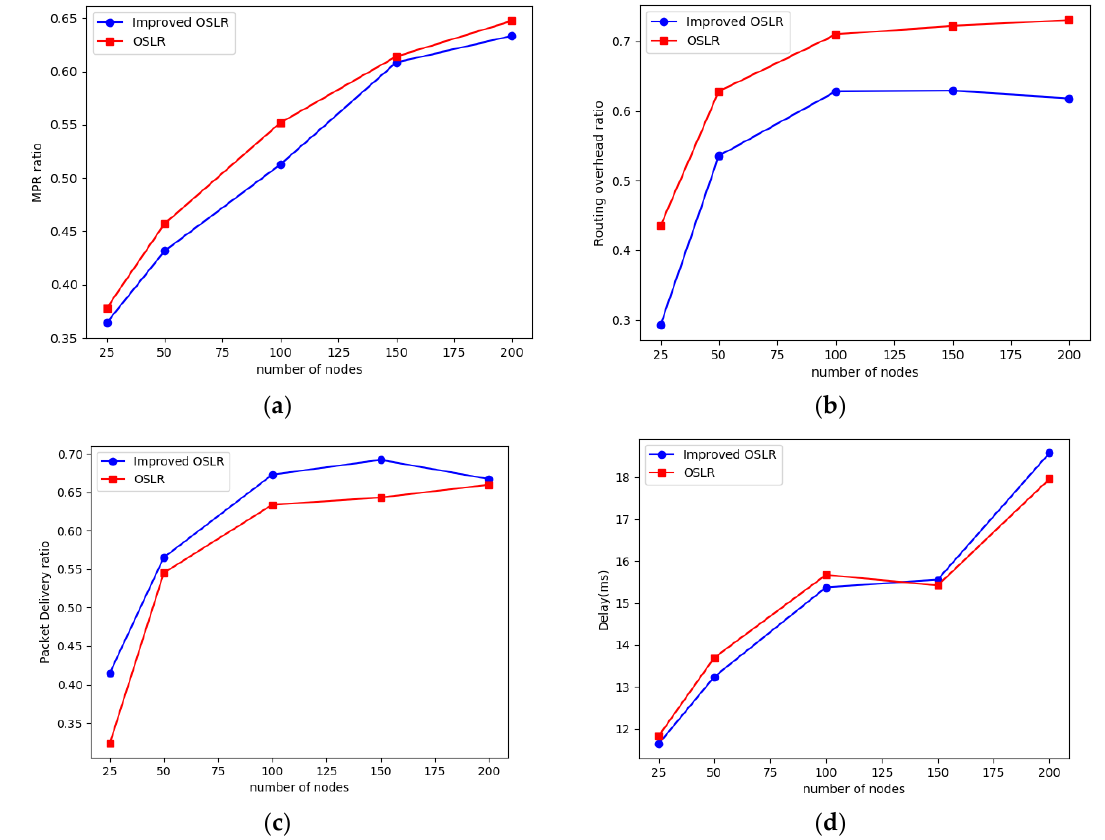
Figure 5. These results show the simulation results comparing OLSR and the improved OLSR